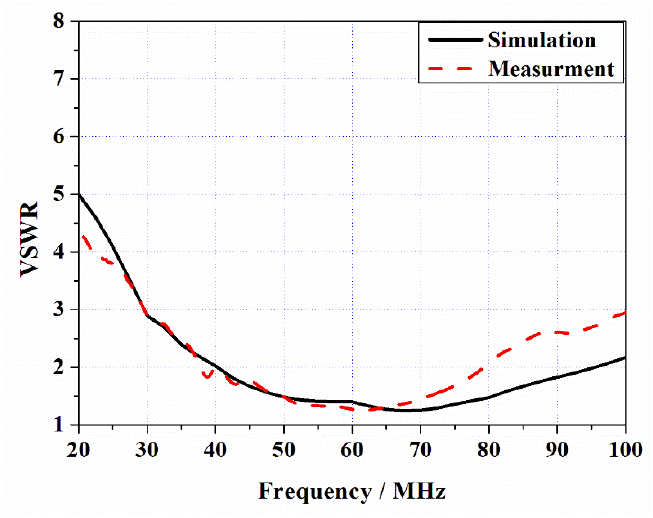
Figure 7. Voltage standing wave ratio (VSWR) of the antenna.